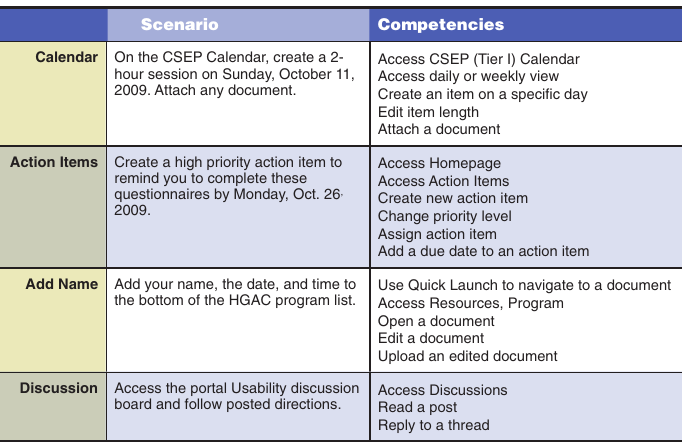
Table 2 Description of Four after Scenario Questionnaire